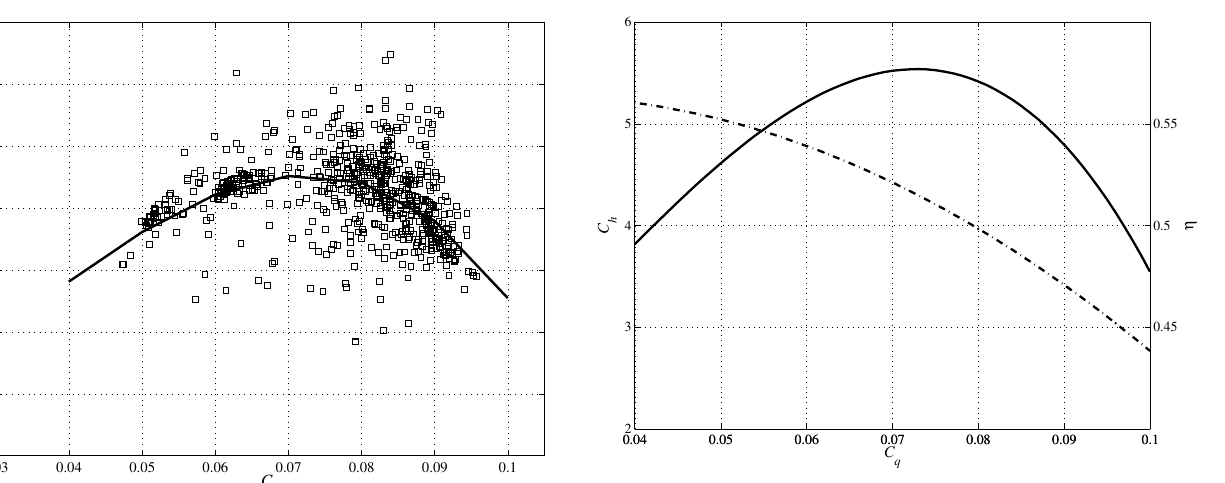
Figure 8. Efficiency values in terms of dimensionless flow, C q : ex- perimental data and fitting.